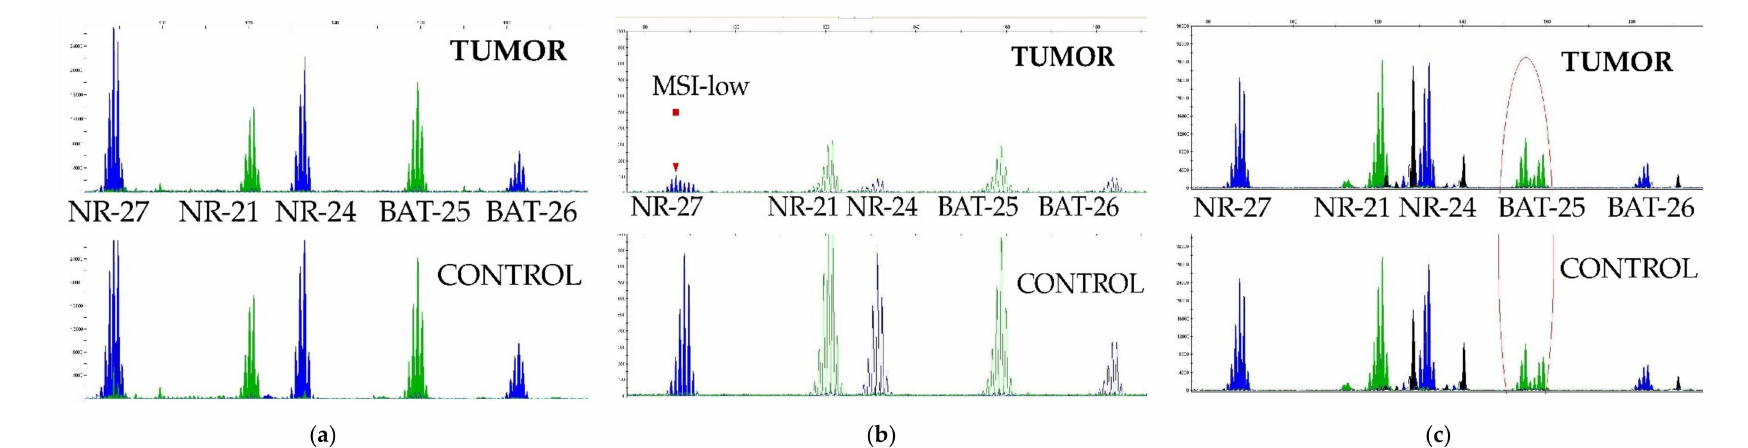
Figure 4. Variants of MSI patterns in STR profiles of PMBCL patients: ( a ) MSS, ( b ) MSI-low with instable NR-27 marker, ( c ) MSS with hereditary heterozygous variant of quasi-homozygous BAT-25